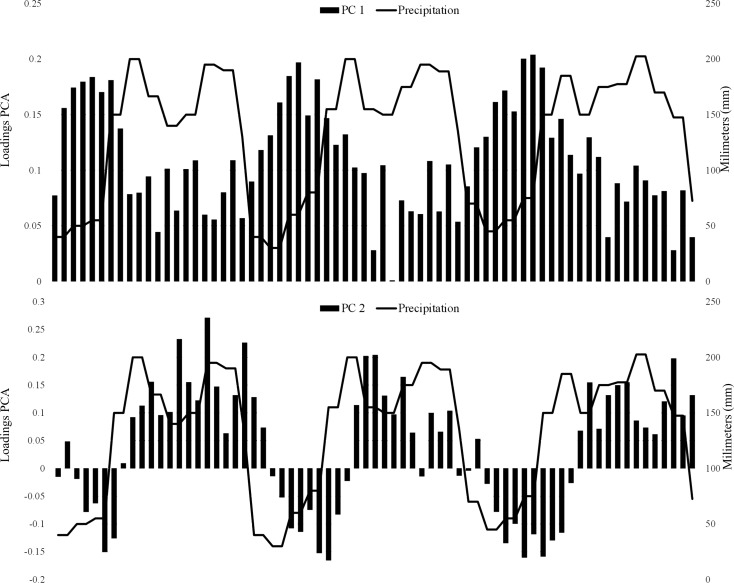
Loading plot from a principal component analysis using NDVI values for the Urabá-Bajo Cauca and Alto Sinú region of Colombia.Black bars indicate the relationship (positive or negative) of the principal components with the dates of the NDVI values. Black line represents the average monthly rainfall for the study area (data from Instituto de Hidrología, Meteorología y Estudios Ambientales de Colombia IDEAM, Octubre 2016).